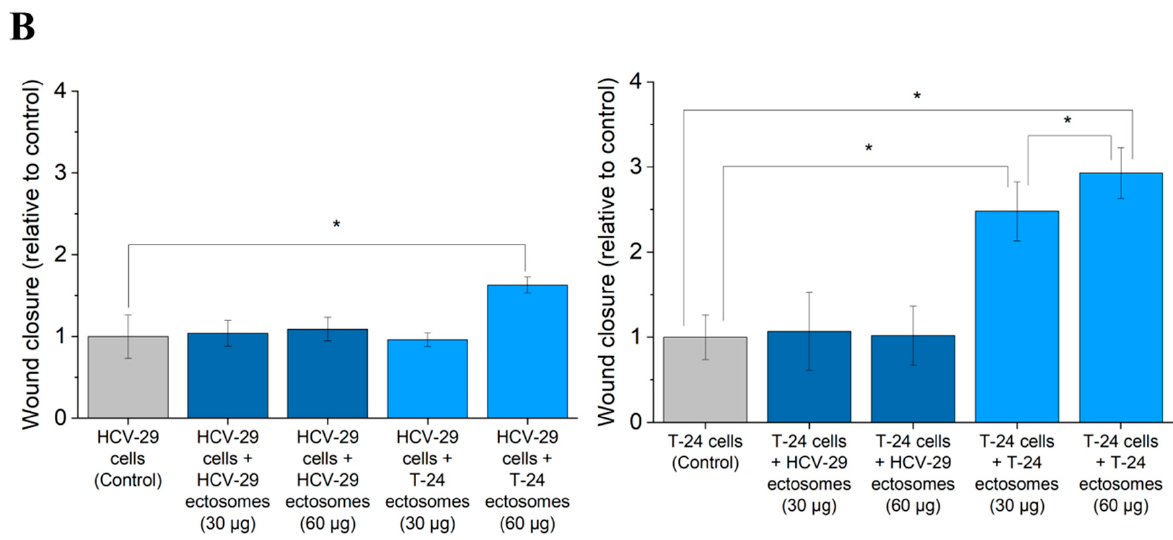
Figure 9. Effect of incubation of T-24 urothelial bladder carcinoma and HCV-29 normal ureter epithelial cells with ectosomes released by these cell lines. Wound healing assay was performed after 18 h of incubation with ectosomes. ( A ) Representative images were taken at 0 h and at 18 h. ( B ) Graphs presenting the relative rate of wound closure calculated from three repetitions. “*” denotes statistically significant differences (Tukey’s post-hoc test, p -value < 0.05).